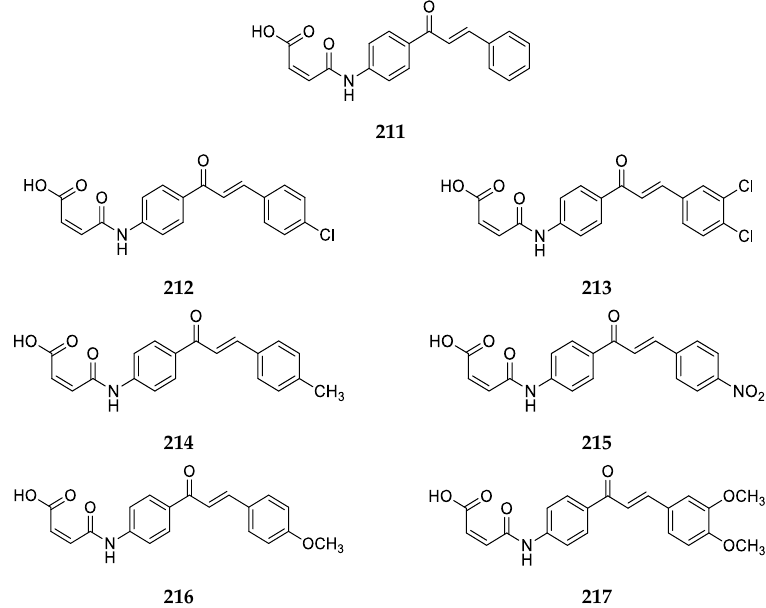
Figure 67. Chemical structures of N -4-aminochalcone maleamic acid derivatives with substitution on ring B.